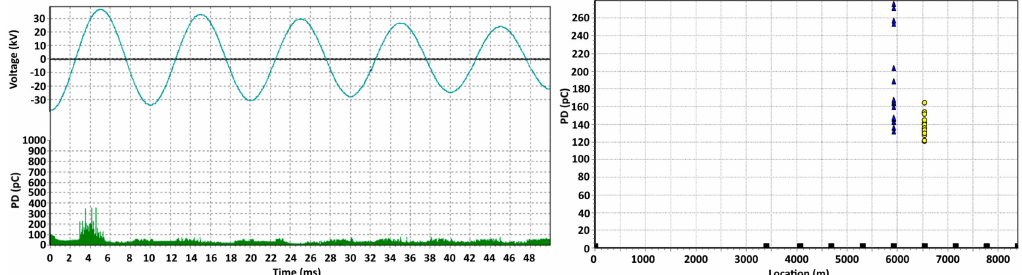
Figure 8. Phase-resolved PD pattern at 1.4 Uo (left), PD mapping showing the complete string length with the localized PD concentrations at the wind turbines (WTG) at WTG 5 and WTG 6. The squares are the locations of the WTGs in the string